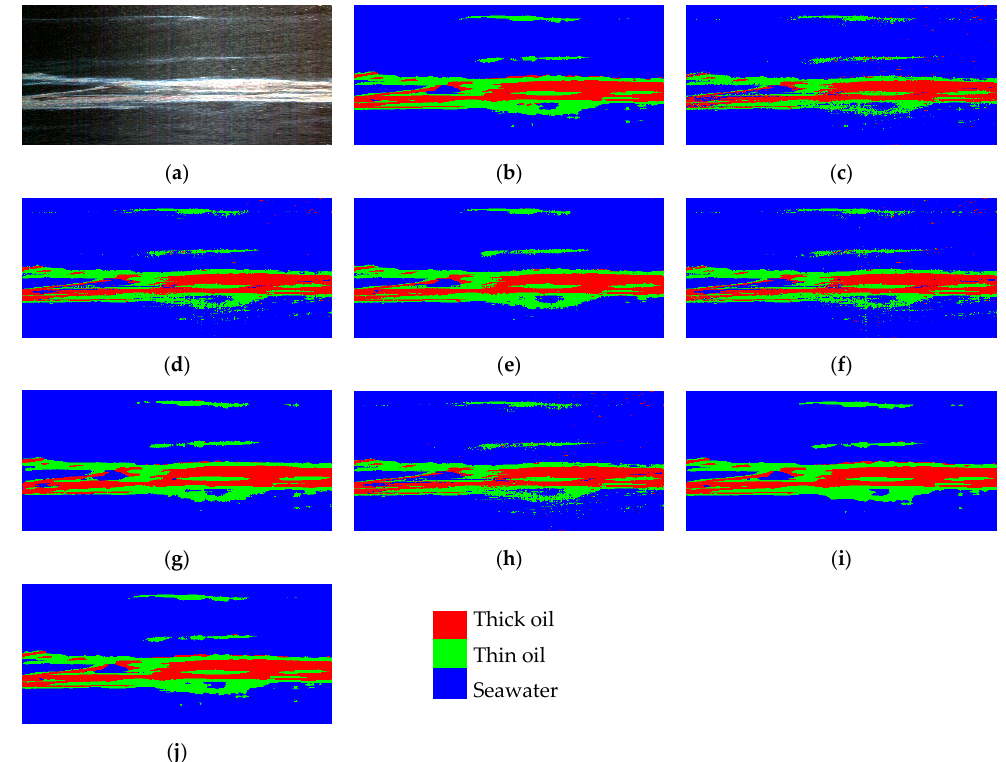
Figure 7. Hyperspectral Oil Spill Detection Results of Dataset 2. ( a ) False-color image. ( b ) Ground truth. ( c ) RF. ( d ) SVM HSI . ( e ) SVM HSI&GLCM . ( f ) NN. ( g ) LetNet-5. ( h ) SPE-CNN. ( i ) SPA-CNN. ( j ) SSFIN. Table 9. The precision, recall, and F1-score for dataset 1 and dataset